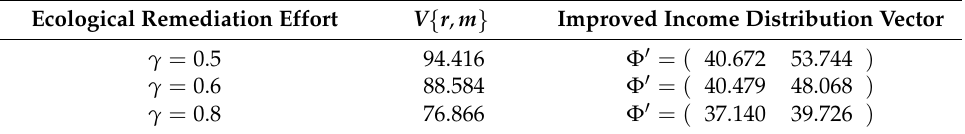
Table 6. Income distribution vector under different ecological remediation efforts γ .